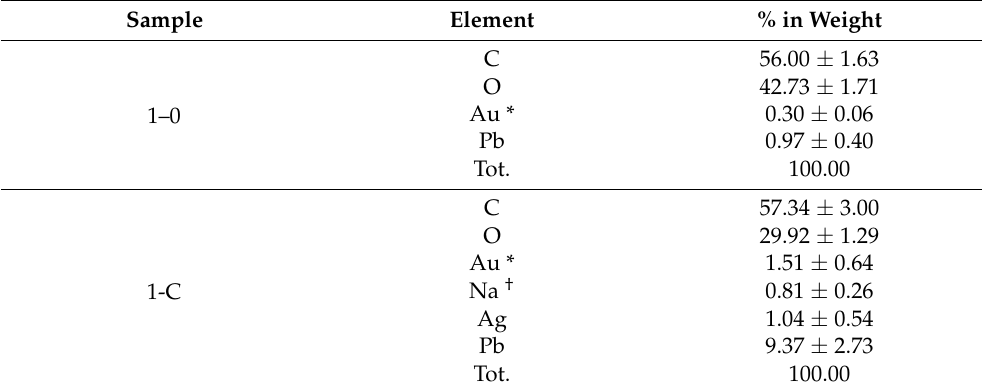
Table 2. Elemental composition of the AgNCs-free and AgNCs hydrogels after the filtration of a 1500 ppm of Pb(II)